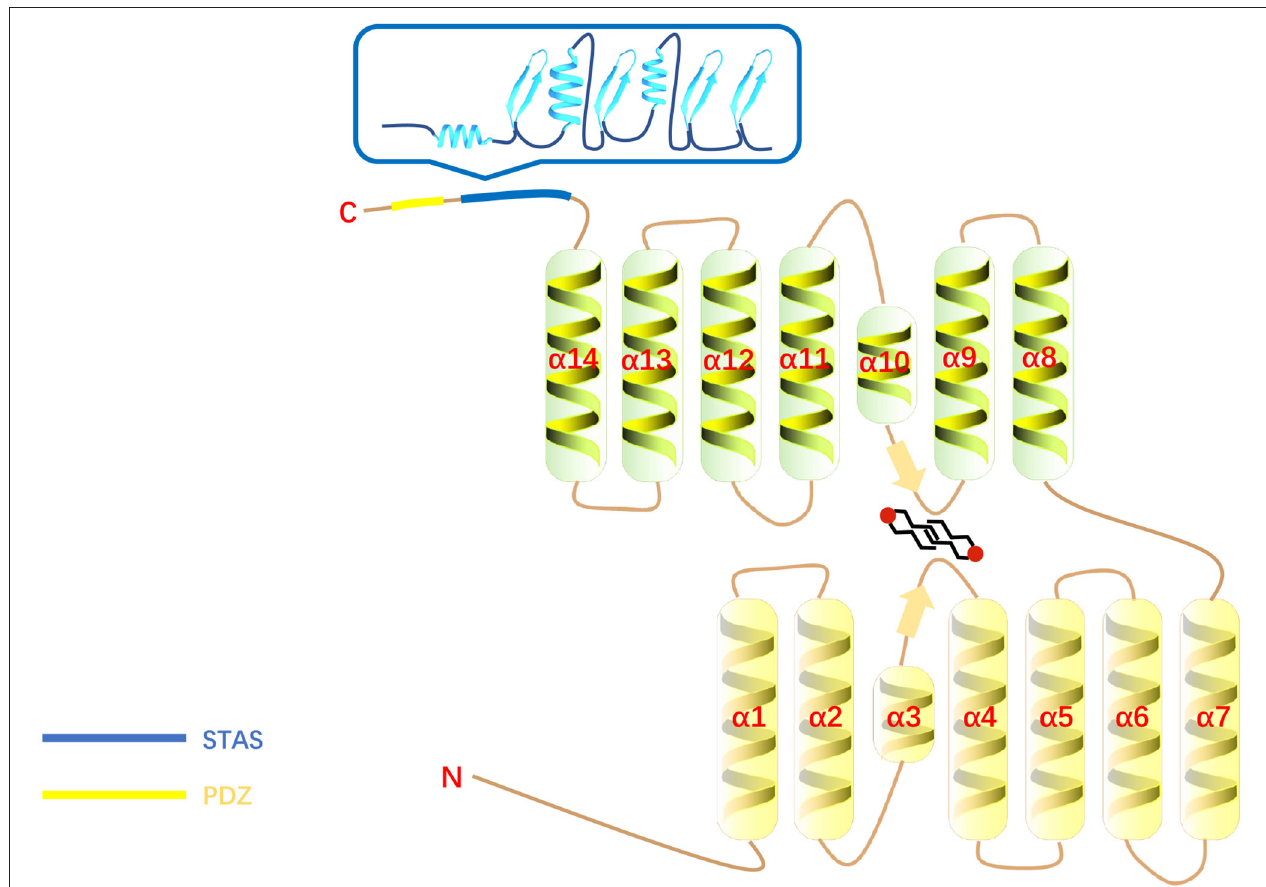
FIGURE 1 | The structure of SLC26A6. The blue box is the STAS